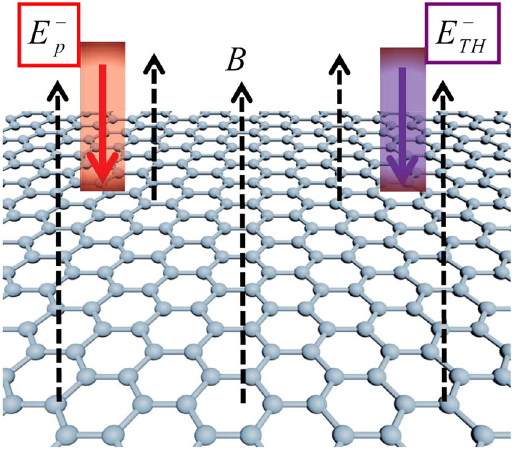
Figure 1. The geometry of the proposed scheme. The infrared probe pulse and THz switch pulse are perpendicularly incident on the single-layer graphene (the monolayer graphene is regarded as a perfect two- dimensional (2D) crystal structure in the x − y plane) placed in a magnetic field B , in which both two optical fields and magnetic field are along the z